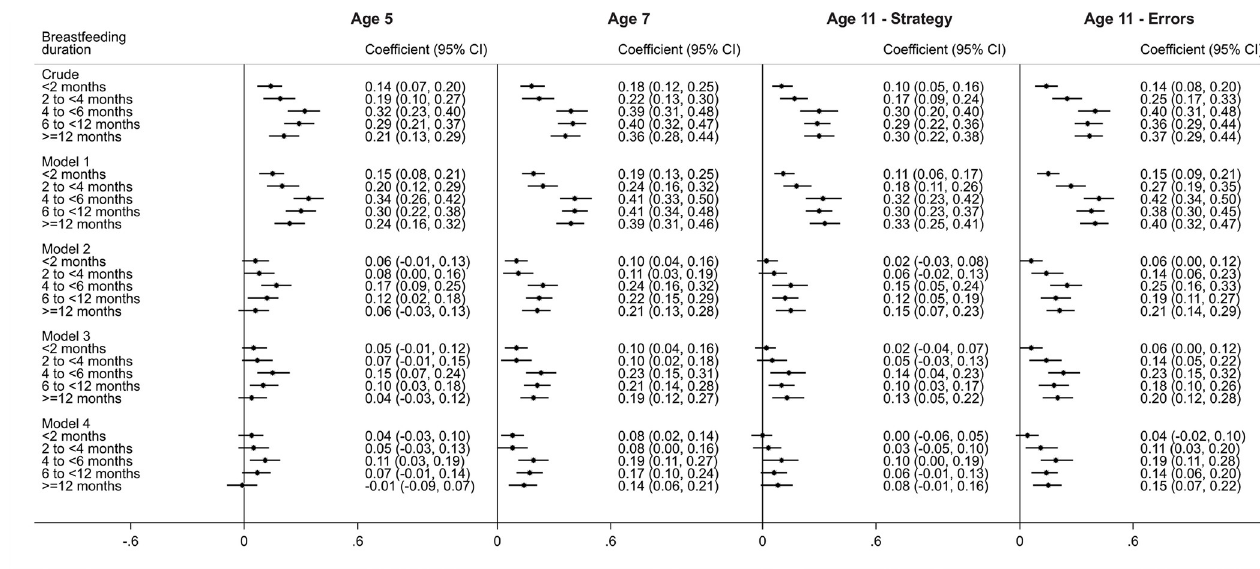
Fig 5. Association between breastfeeding duration (any breastfeeding) and standardised cognitive spatial scores (mean: 0; SD: 1) between ages 5 and 11, UK Millennium Cohort Study (n = 7,582). All categories of BF duration are compared to “Never breastfed” as the reference category. Model 1: Adjusted for gestational age at birth, maternal ethnicity and languages spoken in household. Model 2: Adjusted for Model 1 + Socioeconomic position (maternal education and highest social class in household). Model 3: Adjusted for Model 2 + other confounding factors (older siblings in household, mother working outside the home, partnership status, maternal alcohol use during pregnancy and smoking during pregnancy). Model 4: Adjusted for Model 3 + Maternal cognitive score.